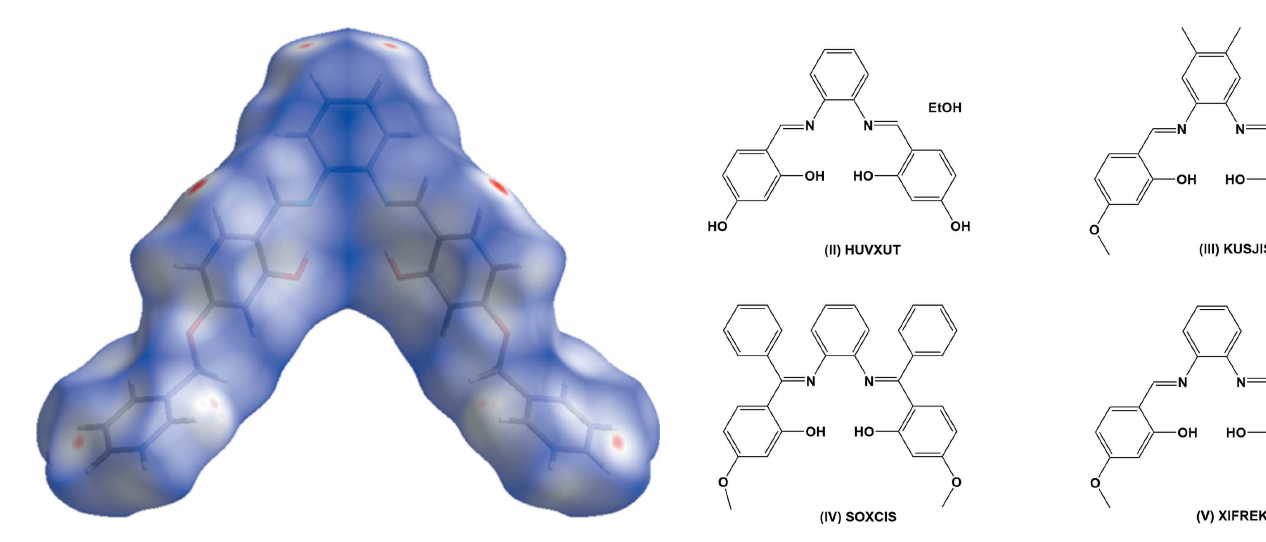
Figure 3 View of the Hirshfeld surface of (I) mapped over d norm .